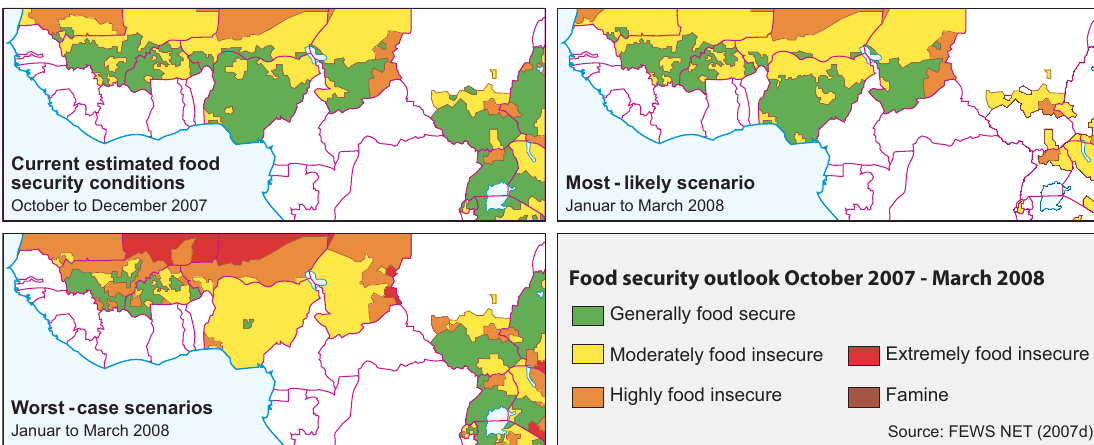
Fig. 6. FEWS NET – Food Security Outlook from October 2007 until March 2008.